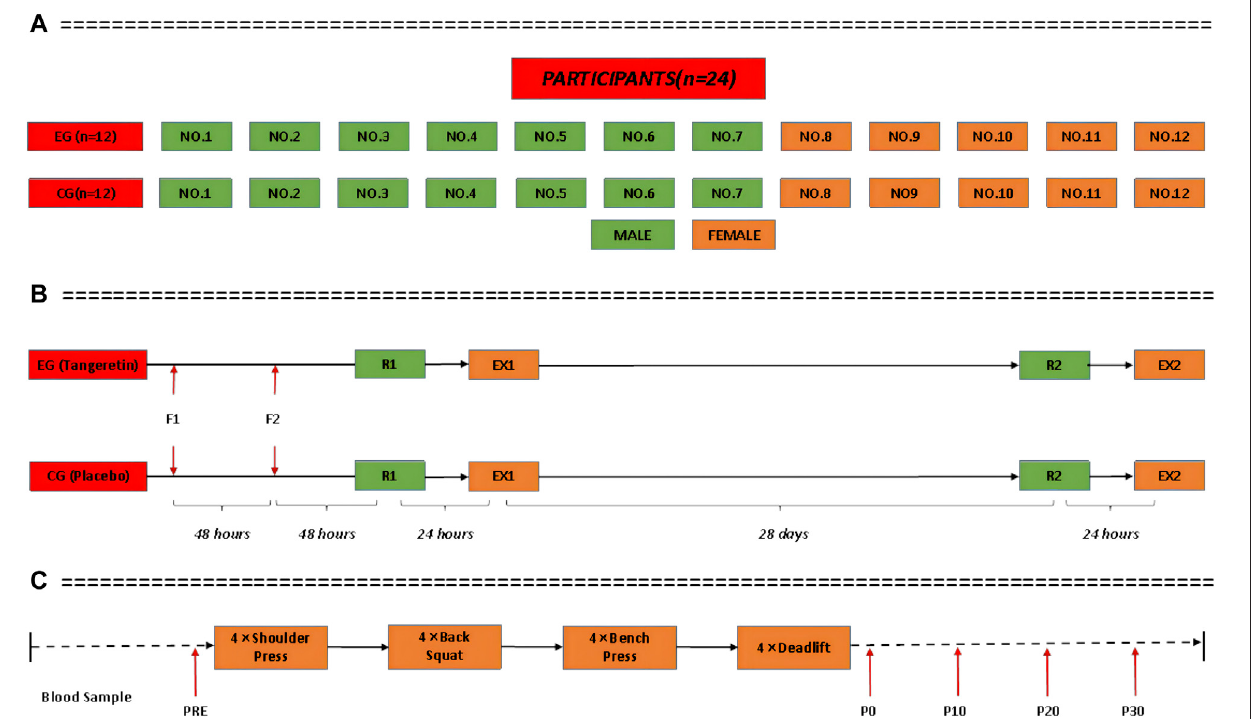
FIGURE 3 | Participants paired according to sex, height, weight and sports